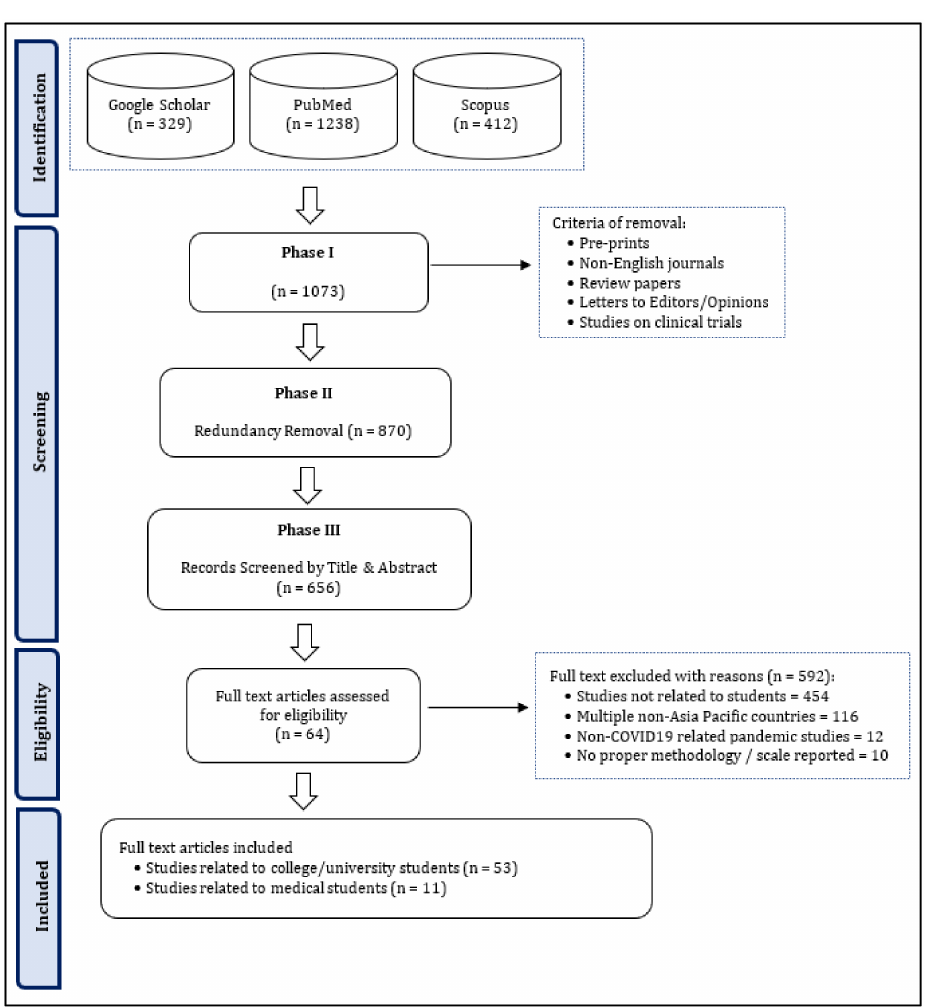
Figure 1. Flow diagram that describes the flow of information through the review’s study search and